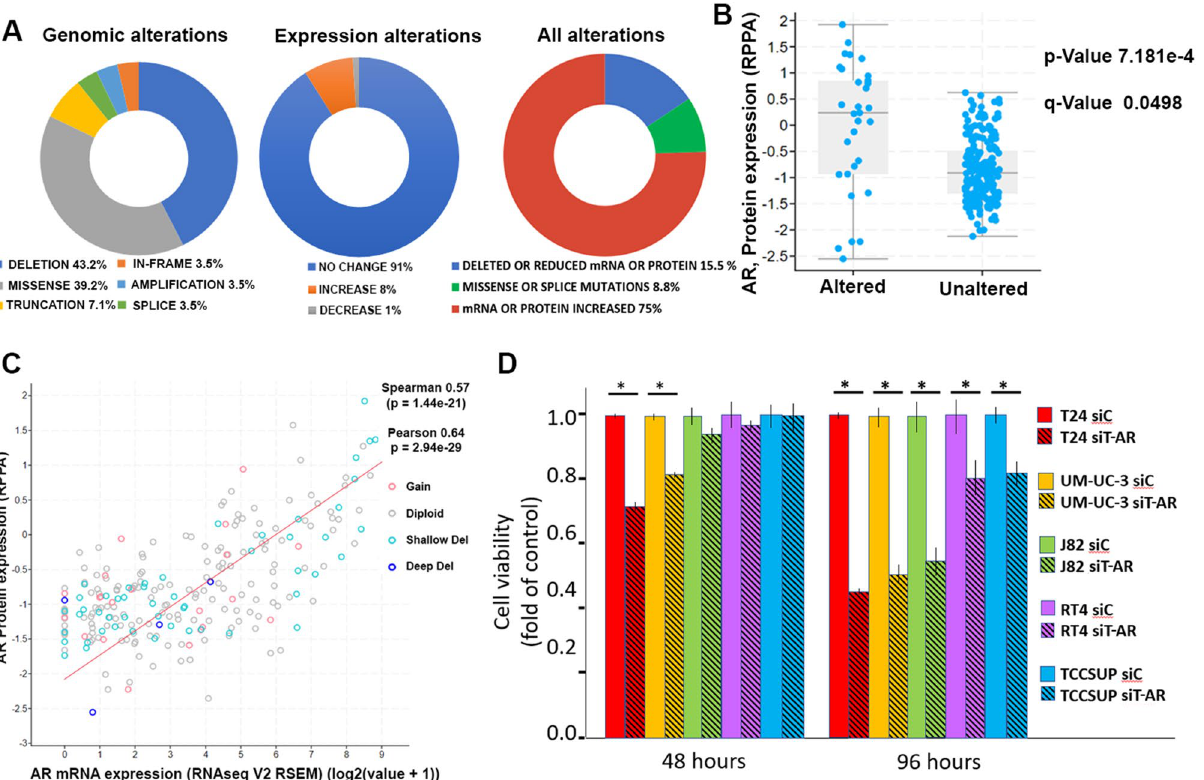
Figure 1. AR genomic and expression alterations in high grade BlCa. ( A ) AR alterations identified in bladder high grade malignancies (cBioPortal). Left panel- genetic alterations, middle panel- expression alterations, right panel—all alterations. ( B ) AR expression alterations correlated with increased AR levels. ( C ) Correlation between AR transcript and protein expression are statistically significant. ( D ) AR depletion reduces cell viability in multiple cells in a time dependent manner. The analysis was conducted in triplicate. * P -value <